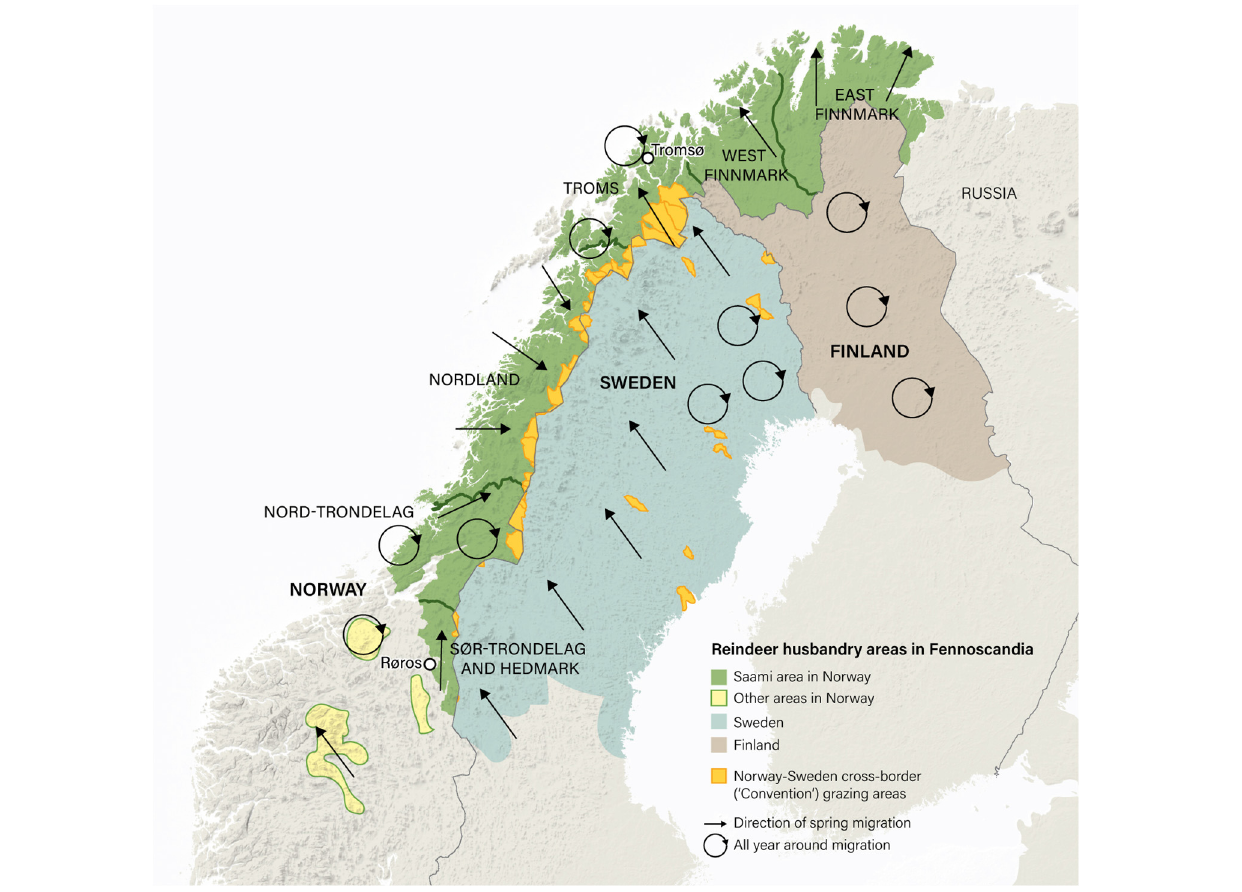
FIGURE 3 | Saami reindeer pastoralism in Norway, Sweden and Finland. The Saami reindeer husbandry area in Norway (green shading) constitutes 141,000 km 2 of utmark (uncultivated land, including forests, meadows, moorland and mountains). This area is equivalent to 40% of the entire country. It is in turn divided into six ‘reindeer pasture areas’ (Troms, East Finnmark, West Finnmark, Nordland, Nord-Trøndelag and Sør-Trøndelag and Hedmark). The map also shows the reciprocal cross-border (‘Convention’) grazing areas used by Norwegian Saami in Sweden and vice versa (orange shading). These constitute an area of ∼ 14,000 km 2 . The Convention on cross-border grazing between Norway and Sweden is currently in abeyance (see text). Sources: Government of Norway (2010) and Pape and Löffler (2016).